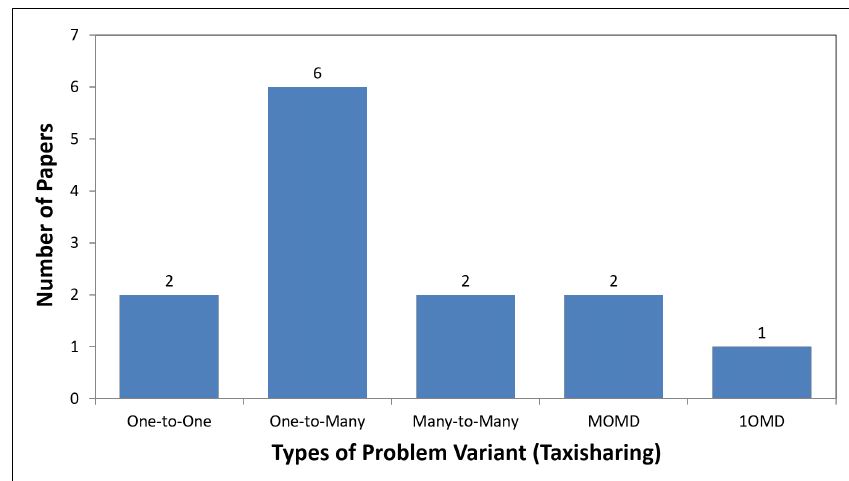
Figure 5. Distribution of Papers based on the Problem Variants: Taxisharing.